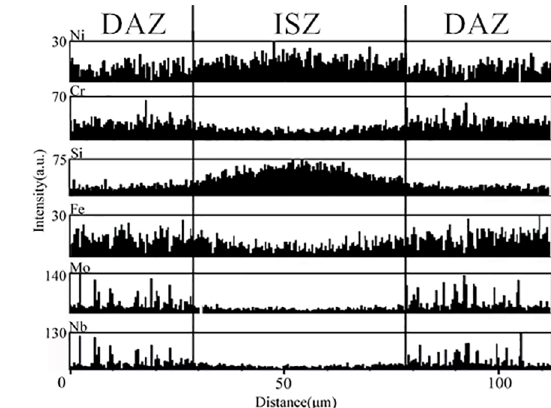
Figure 6. Element distribution of the brazed